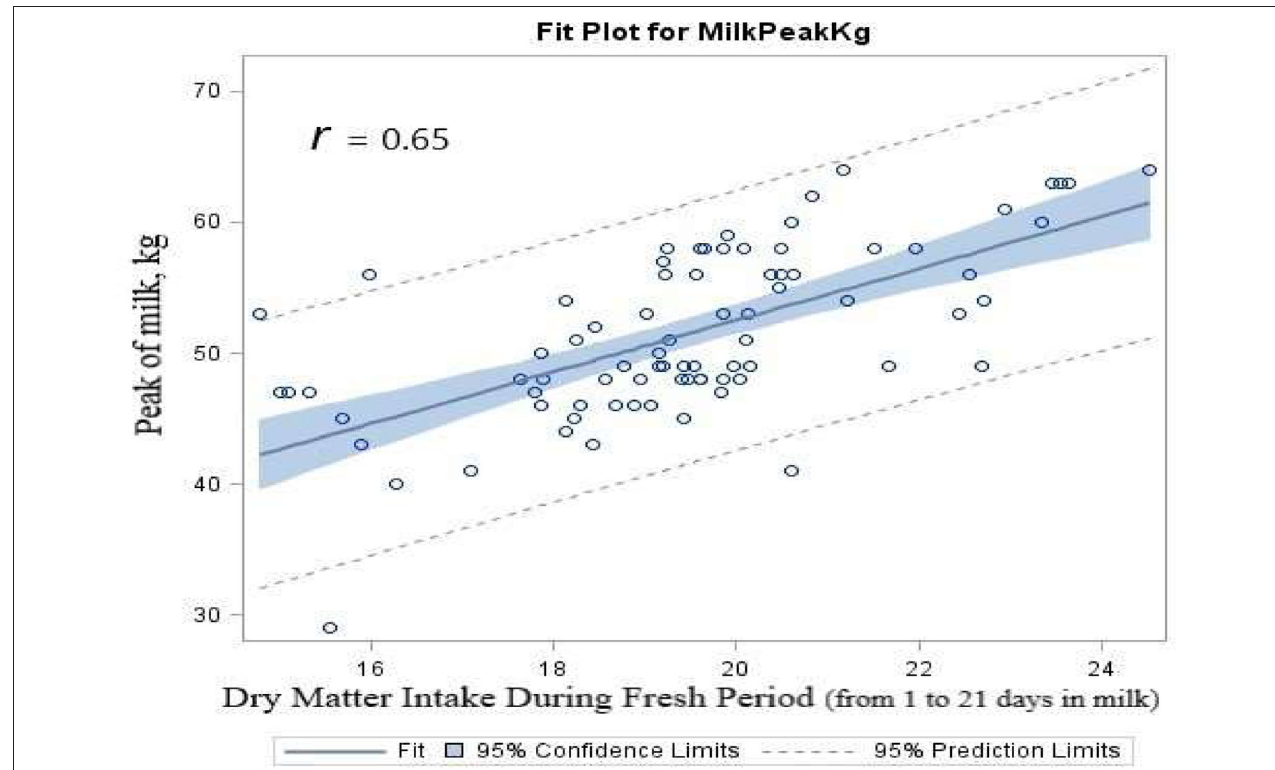
FIGURE 4 | Scatterplot of the peak of milk (kg) by dry matter intake that was consumed during the fresh period (first 3 weeks of lactation) overlaid with the fit line, a 95% confidence band and lower and upper 95% prediction limited, for dairy cows fed either ruminally protected Lys or Met or the combination during the transition